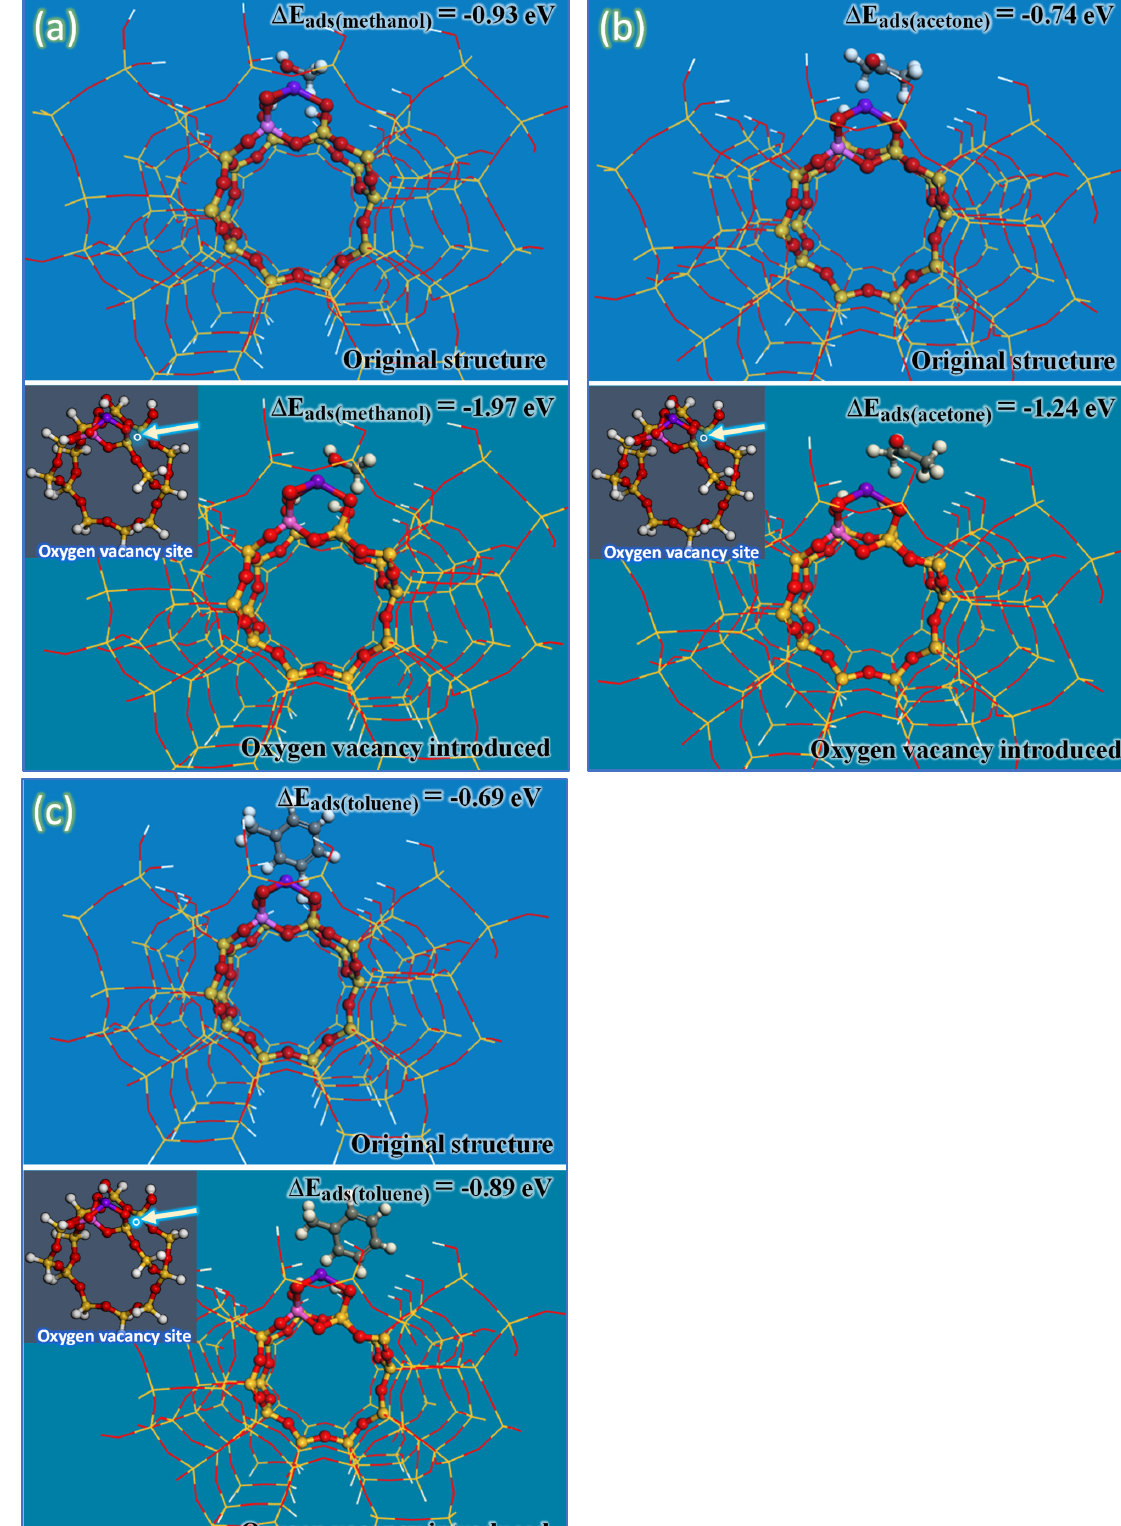
Figure 11. Schematic diagram of intrinsic adsorption before modification and optimized adsorption after introducing oxygen defects for ( a ) methanol, ( b ) acetone, and ( c ) toluene. (Dark gray, white, red, yellow, pink, and purple circles denote C, H, O, Si, Al, and Mn atoms,